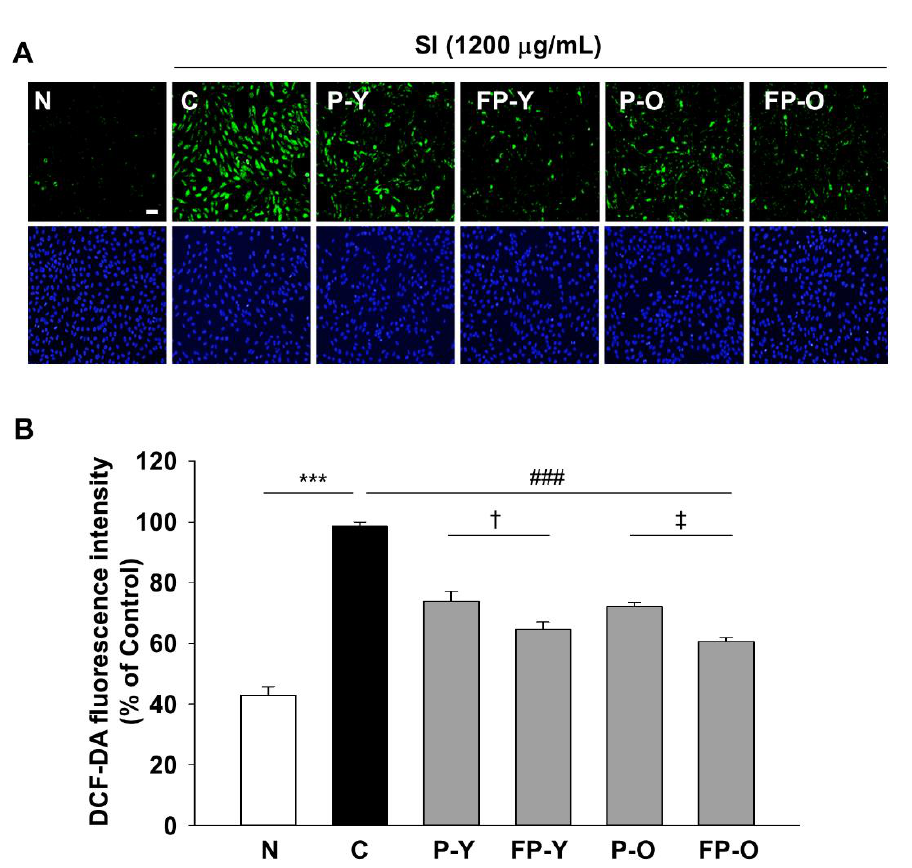
Figure 2. Effects of fermented paprika (FP) on SI-induced ROS generation in ARPE-19 cells. Cells were exposed to SI after incubated with 500 μg/mL of P (-Y or -O) and FP (-Y or -O) extract for 24 h. Intracellular ROS were measured using DCFH-DA (2′,7′-dichlorofluoresin diacetate) assay. ( A ) Representative fluorescence micrographs depicting ROS generation in SI-exposed ARPE-19 cells for 24 h after pretreatment with P (-Y or -O) and FP (-Y or -O) extract at 500 μg/mL (upper panel). Total (DAPI stained) number of cells were presented in lower panel. ( B ) DCF-DA intensity was quantified using Image J. The magnification was × 200. *** p < 0.001 vs. N, ### p < 0.01 vs. C, † p < 0.05 vs. P-Y, ǂ p < 0.01 vs. P-O. Values are means ± SEM. Significant differences between the groups were determines by ANOVA followed by Duncan’s multiple range test. N, Normal; C, Control; P-Y, Yellow Paprika; P-O, Orange Paprika; FP-Y, Fermented P-Y; FP-O, Fermented P-O.